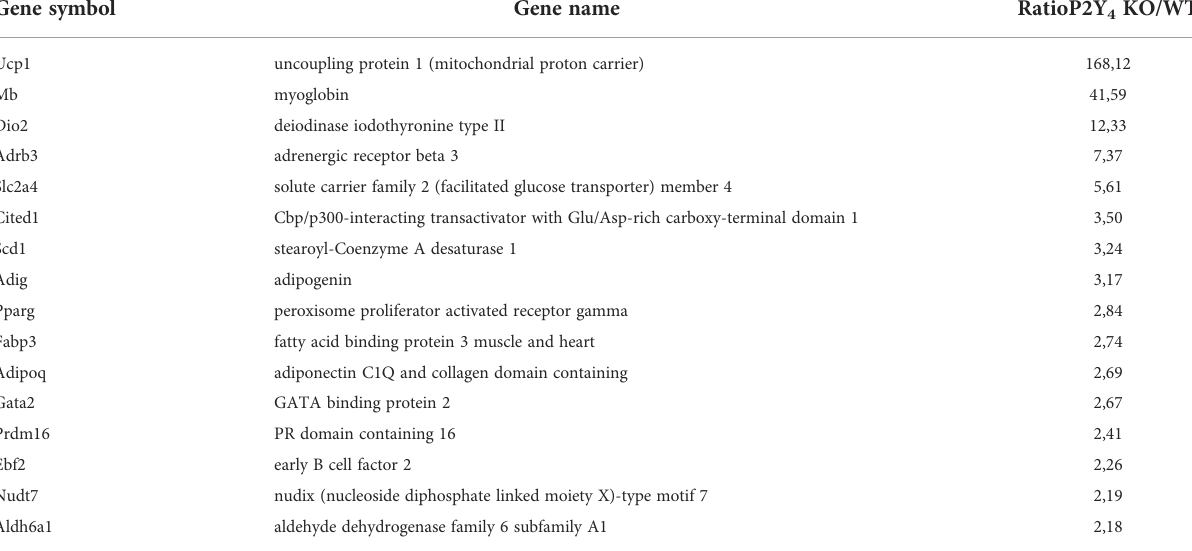
TABLE 1 Genes involved in brown adipocyte differentiation and differentially regulated in the PAT of P2Y 4 KO compared to the PAT of WT mice. Gene symbol